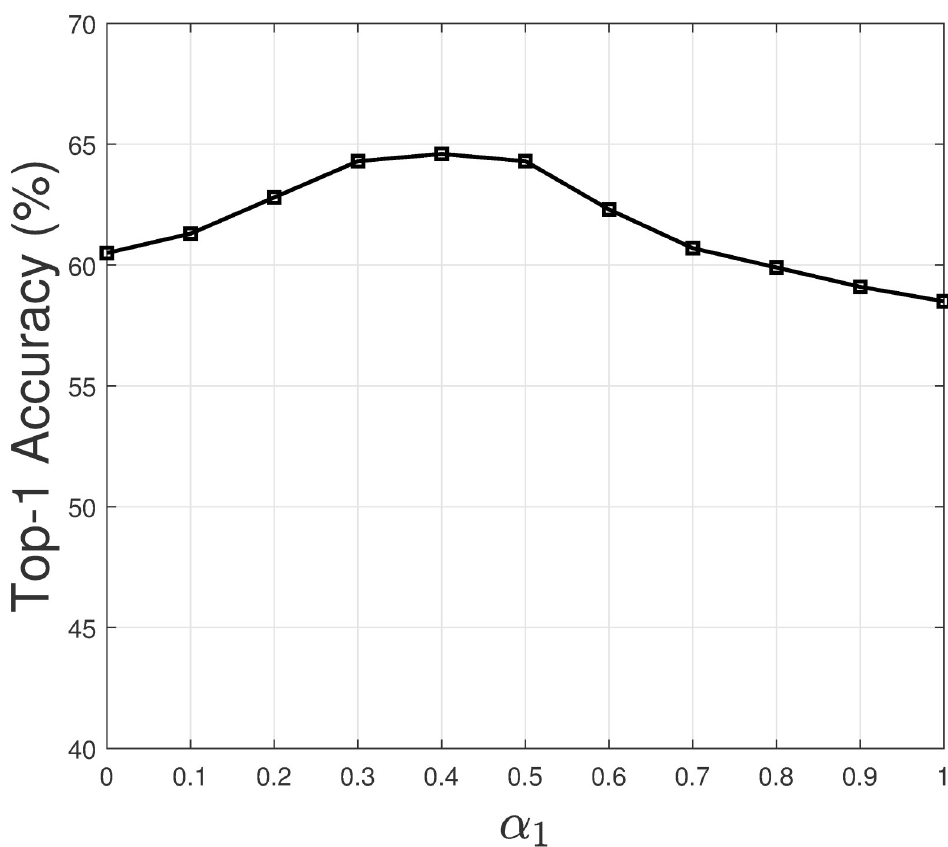
Fig 8. Top-1 accuracy when α 1